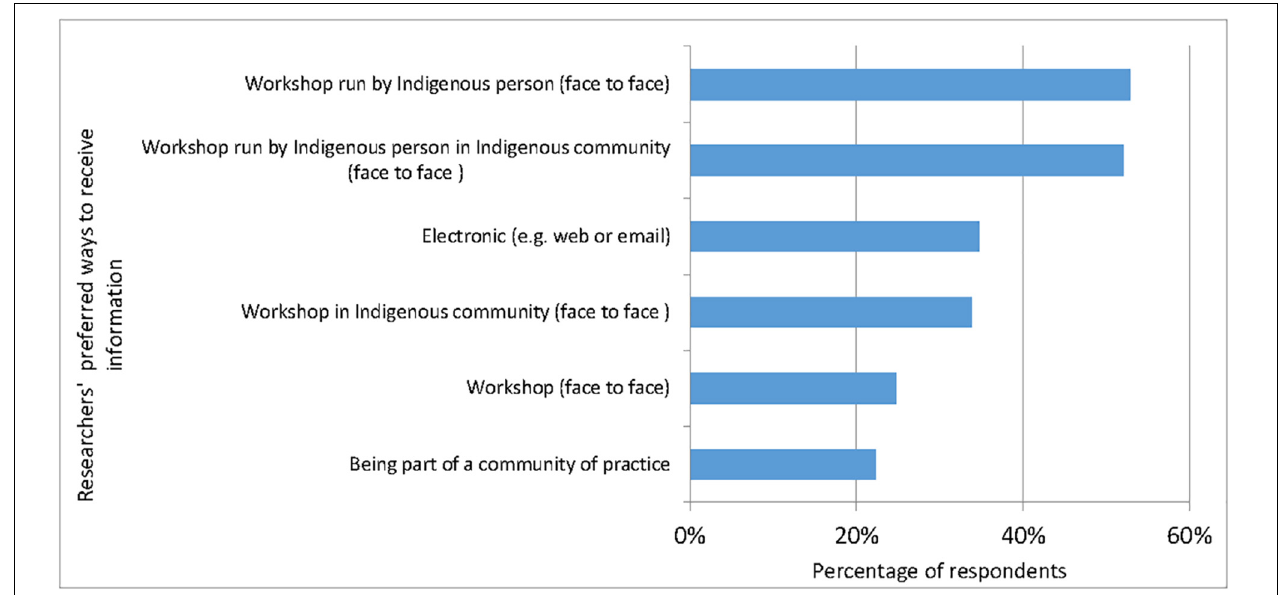
FIGURE 6 | Researchers’ preferred ways for receiving information on engaging with Aboriginal and Torres Strait Islander people measured as a percentage of survey respondents ( n =